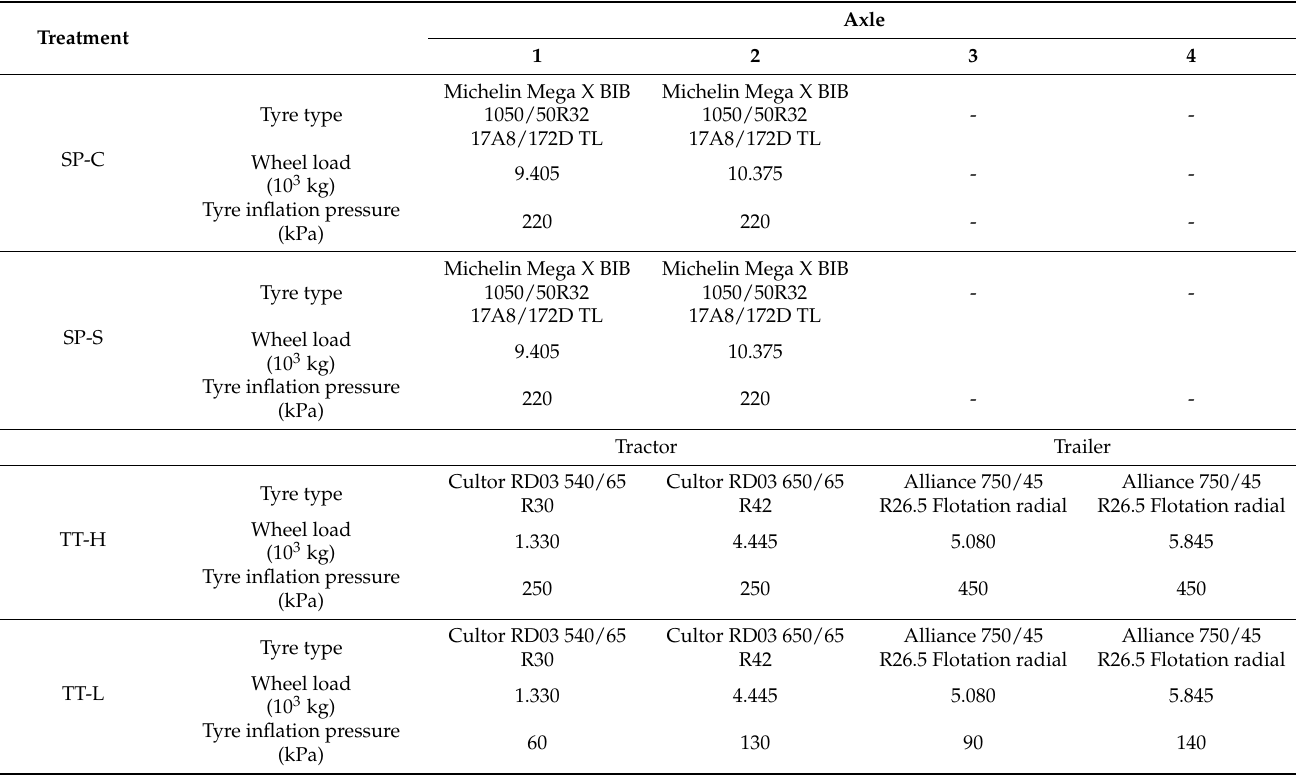
Table 2. Tyre properties and wheel load for each axle of the four slurry application methods. The numbering of the axles is given from front to rear.